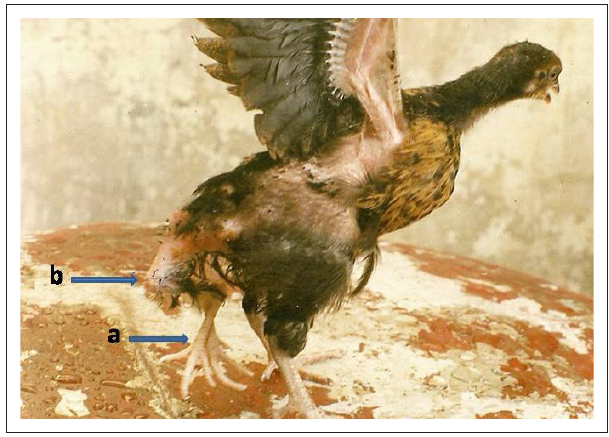
a, the right lateral view shows an extra two limbs; b, shows a rudimentary wing. FIGURE 1: Polymelia in an eight-week-old Nera black chicken, seen from the right